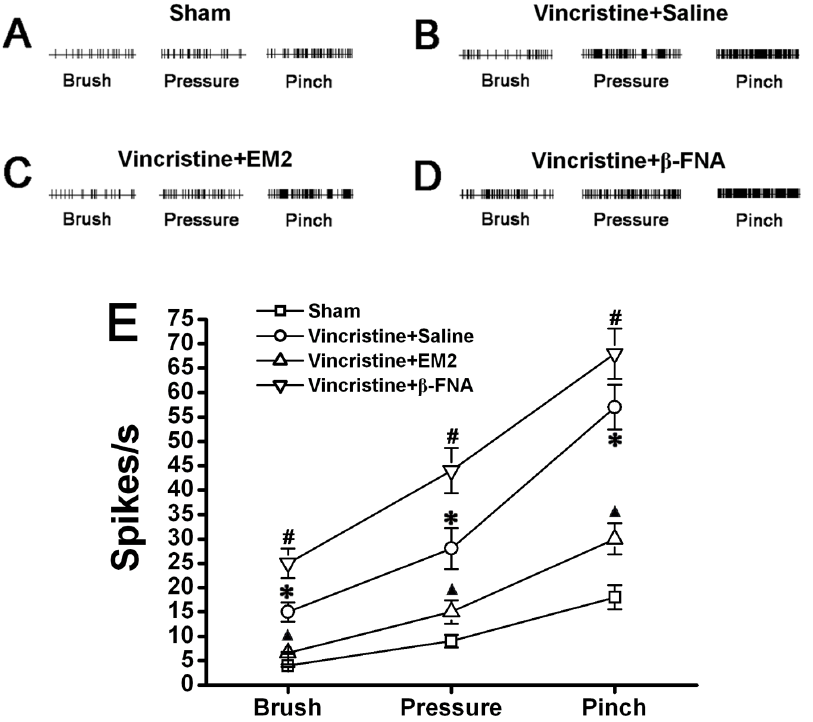
Figure 5. Decreased spinal EM2 contributed to spinal central sensitization in vincristine treated rats. Comparative recordings of responsiveness of spinal dorsal horn wide dynamic range (WDR) neurons to mechanical (brush, pressure and pinch) stimuli in Sham group (A), Vincristine + Saline group (B), Vincristine + EM2 group (C) and Vincristine + b -FNA group (D). (A–D) The responsiveness of WDR neurons was gradedly increased with the increase in mechanical intensity (brush, pressure and pinch). (E) Compared to Sham rats, the responsiveness of WDR neurons was significantly enhanced with a distinct leftward shift of the stimulus-response functional curve in vincristine treated rats. While the exogenous EM2 significantly attenuated the increased responsiveness, the mu-opioid receptor b -FNA aggratated the increased responsiveness. *P , 0.05 vs. Sham group; m or # P , 0.05 vs. Vincristine + Saline group.